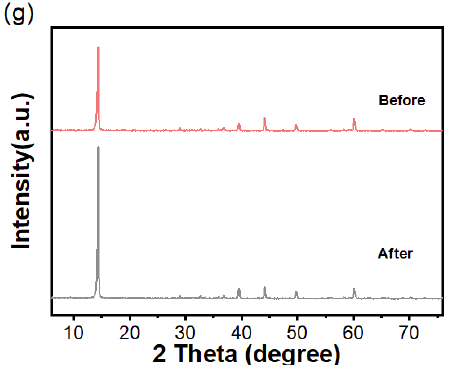
Figure 5. Photocatalytic study of MO degradation, ( a ) time-dependent UV − Vis absorption spectra, ( b ) conversion of MO over various photocatalysts, ( c ) pseudo − first-order kinetics study of the degradation, ( d ) degradation rate constant of as − fabricated samples, ( e ) recycling and ( f ) radical scav- enging activity during the decomposition of MO over MC − 20% under visible light, ( g ) Comparison of XRD analysis of MC − 20% samples before and after photocatalytic.